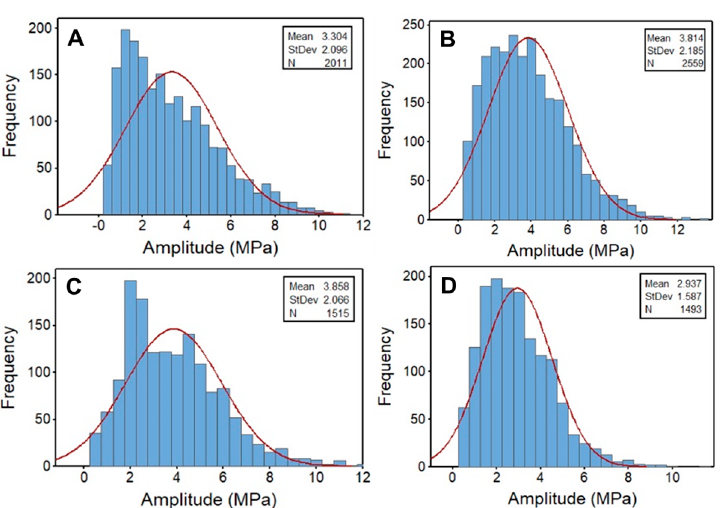
Figure 18. Histogram of the obtained amplitude of the PLC signal: ( A ) Al–0.5wt. %Mg–10wt. % A206 samples, ( B ) Al–0.5wt. %Mg–10wt. % A206/1 wt. % γ Al 2 O 3 samples, ( C ) Al–0.5wt. %Mg–20wt. % A206 samples, and ( D ) Al–0.5wt. %Mg–20wt. % A206/1 wt. % γ Al 2 O 3 samples.